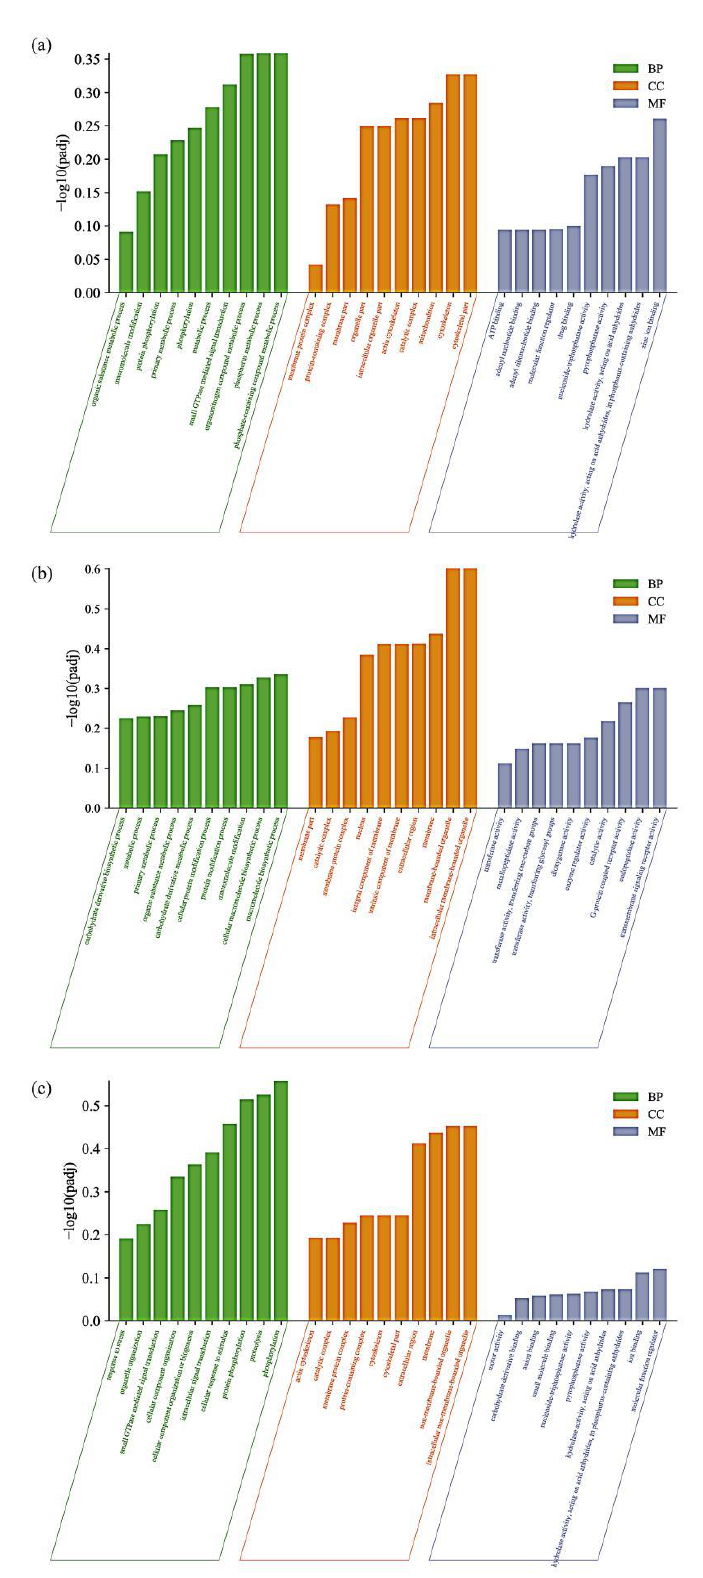
Figure 4. GO analysis of DEGs in different salinity comparison groups. ( a ) GO analysis of DEGs in the Smsh vs. Smsc; ( b ) GO analysis of DEGs in the Smsh vs. Smsl; and ( c ) GO analysis of DEGs in the Smsl vs. Smsc.